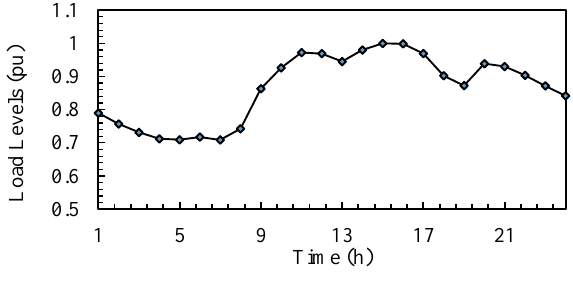
Figure 6. Hourly load profile for individual loads.